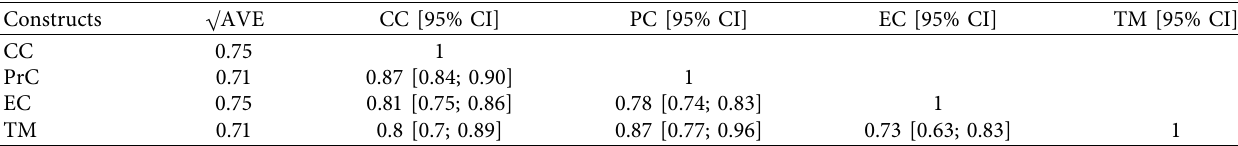
Figure 3: Parallel analysis and scree plots for the 20-item SETE scale. PC: Principal components, FA: Factor analysis. Table 6: Interconstruct correlations and their 95%